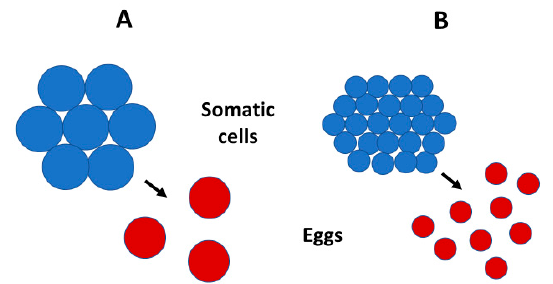
Figure 5. Schematic diagrams showing how the size and number of somatic cells (blue circles) in multicellular organisms tend to parallel the size and number of reproductive propagules (here illustrated as eggs: red circles), following prediction #5 of the Single-Cell ‘Bottleneck’ Hypothesis (SCBH: Table 6). ( A ): An organism with relatively few large somatic cells produces relatively few large eggs. ( B ): An organism with relatively many small somatic cells produces relatively many small eggs. These differences are similarly produced by changes in genome size (see Table A2) and ambient temperature (see Section 4.6).